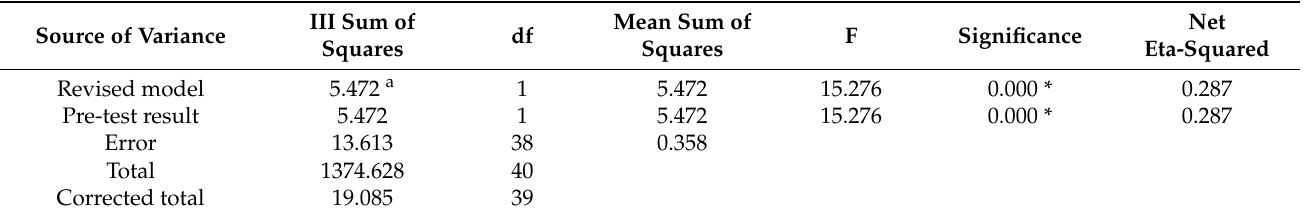
Table 4. Single factor ANCOVA results of students’ post-test scores following the introduction of computational thinking and motion media-based digital teaching in the practical dessert-making